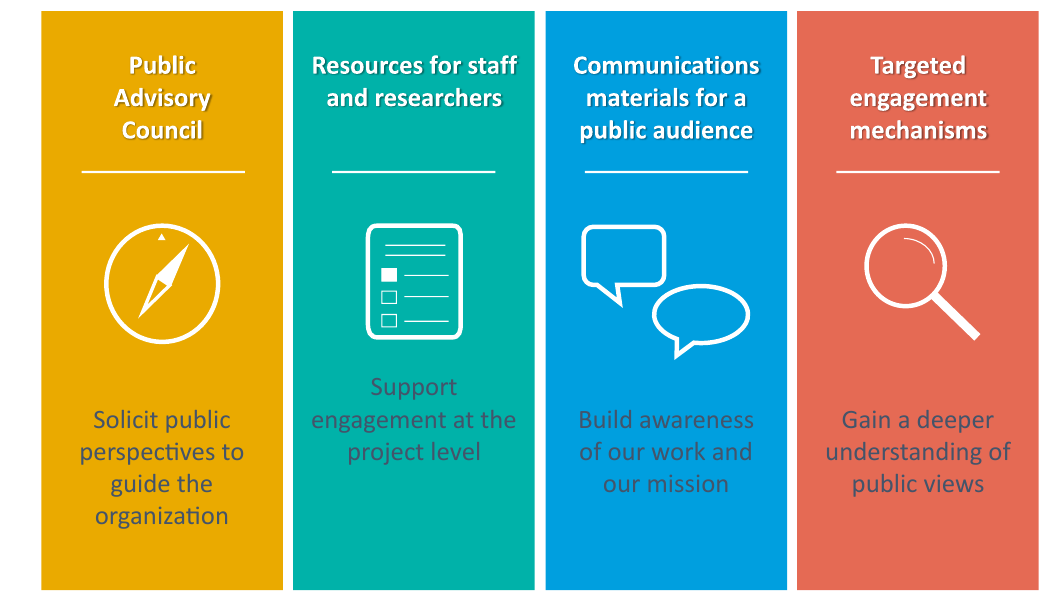
Figure 2: Four key pillars of ICES’ public engagement